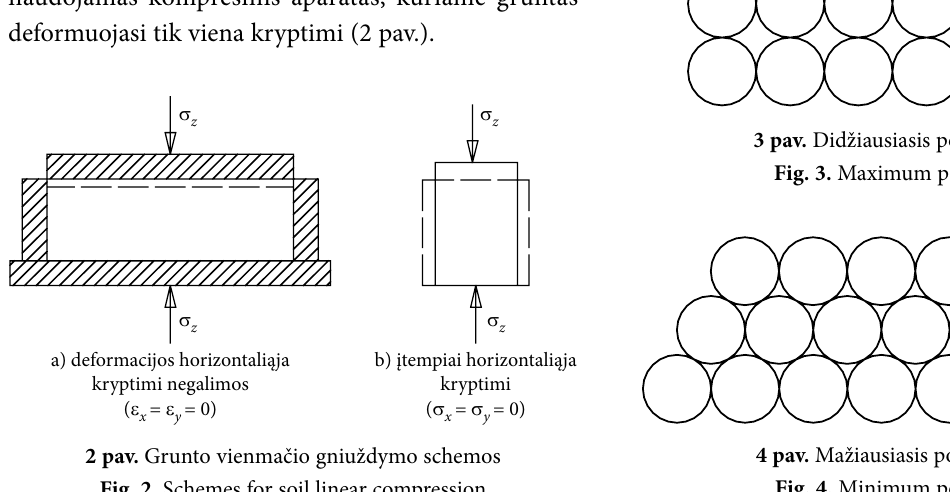
Fig. 2. Schemes for soil linear compression